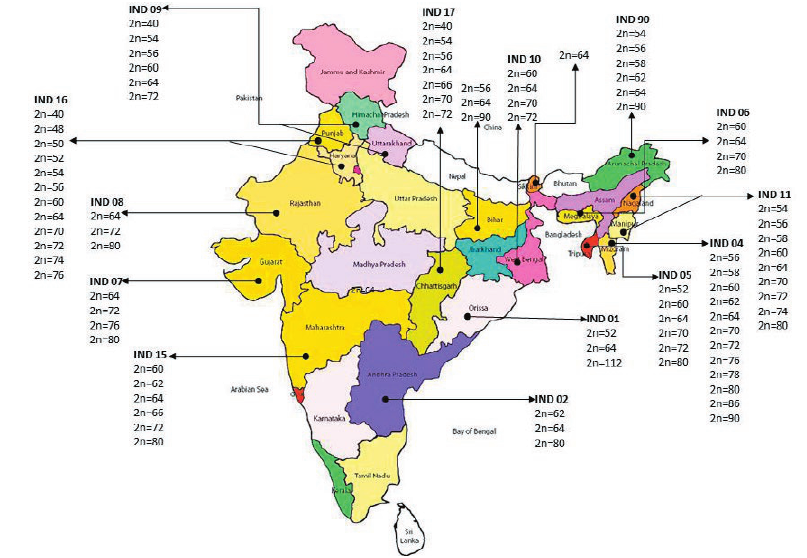
Figure 2. Distribution of S. spontaneum cytotypes (from 2001-2017 collection) in different states of India.